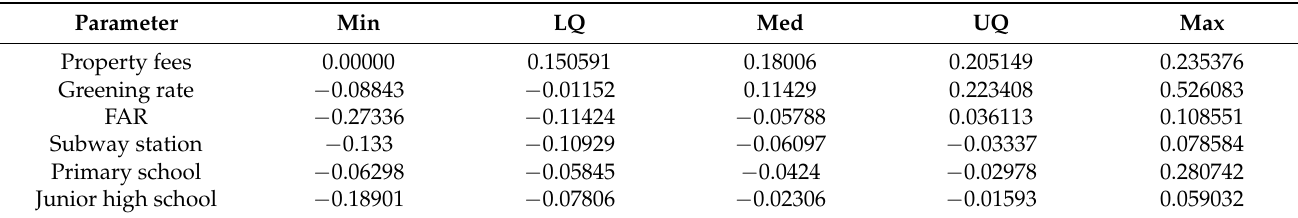
Table 5. RGWR coefficients estimate summaries.